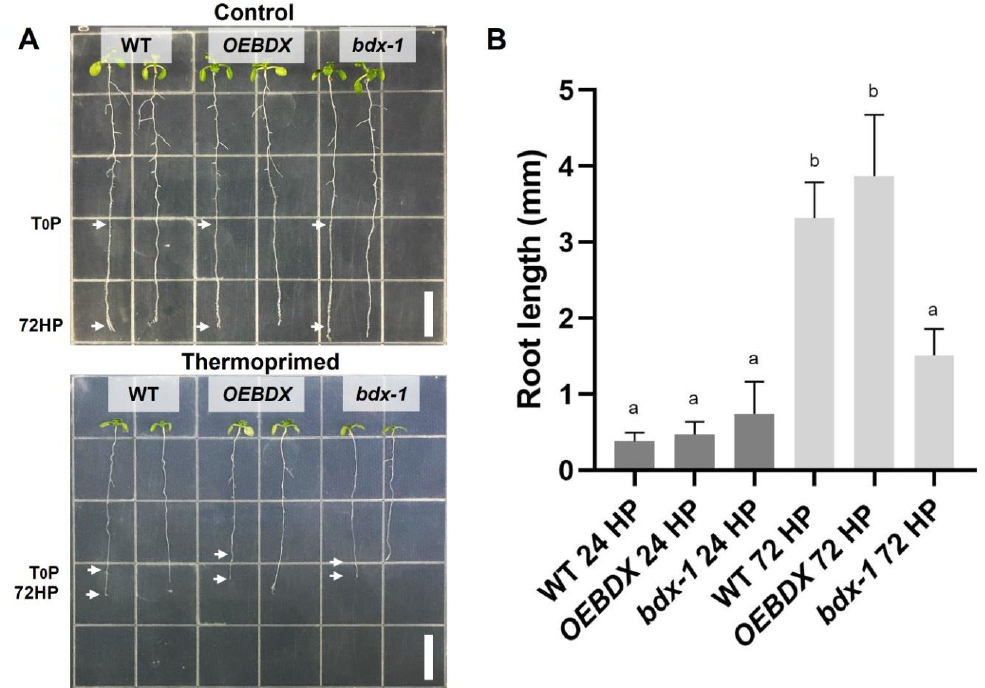
Figure 3. Effect of thermopriming treatment on root growth. ( A ) Seedlings of WT, OEBDX, and bdx -1 were sown vertically on MS medium. The seedlings were exposed to priming treatment, and the comparisons of the root lengths between the lines were performed 72 h after priming. ( B ) Root length average after 24 and 72 h of priming. Error bars indicate SEM (n = 3). An amount of 30 seedlings constituted each biological replicate. Different letters indicate significant differences calculated using one-way ANOVA with post-hoc Tukey’s test ( p < 0.05). White bars = 10 mm.